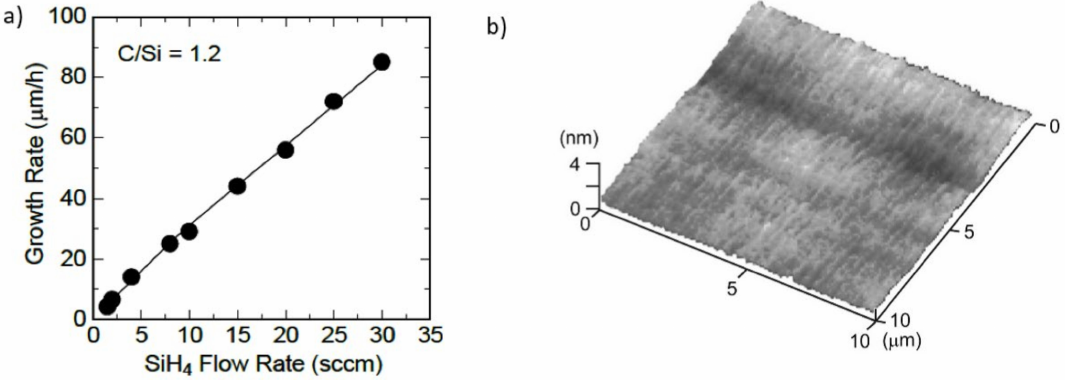
Figure 8. ( a ) SiH 4 -flow-rate dependence of the growth rate at a C/Si ratio (C/Si = 1.2) in the homoepitaxial growth of 4H-SiC(0001) [121,122]. ( b ) AFM results from a 150 mm-diameter 4H-SiC epitaxy grown at 77 µ m/h